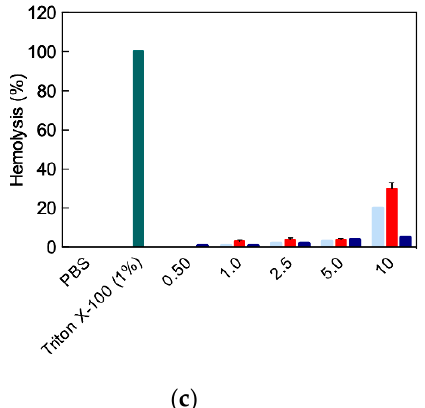
Figure A4. ( a ) Toxicity assessment using the MTT assay in prostate cancer PC-3 cells (solid bars) and in human embryonic kidney (HEK293) cells (patterned bars) of the AD micelles alone, AD in complex with a non-silencing siRNA (nssiRNA/ AD ) and the targeting peptide-decorated AD in complex with a non-silencing siRNA (nssiRNA/ AD /E 16 G 6 RGDK). ( b ) Toxicity assessment using the LDH assay in prostate cancer PC-3 cells (solid bars) and in human embryonic kidney (HEK293) cells (patterned bars) of the AD micelles alone, AD in complex with a non-silencing siRNA (nssiRNA/ AD ) and the targeting peptide-decorated AD in complex with a non-silencing siRNA (nssiRNA/ AD /E 16 G 6 RGDK). ( c ) Hemolysis effect measured via UV absorption at 540 nm for the AD micelles alone, AD in complex with a non-silencing siRNA (nssiRNA/ AD ) and the targeting peptide-decorated AD in complex with a non-silencing siRNA (nssiRNA/ AD /E 16 G 6 RGDK) at different AD concentrations (corresponding to nssiRNA concentrations of 10, 20, 50, 100, and 200 nM, respectively). In all these experiments, the siRNA/ AD /E 16 G 6 RGDK nanoassemblies were prepared using 50 nM siRNA, siRNA/ AD N/P = 10, and AD /E 16 G 6 RGDK molar ratio = 5. Adapted from [8] with the permission of the American Chemical Society, 2018.